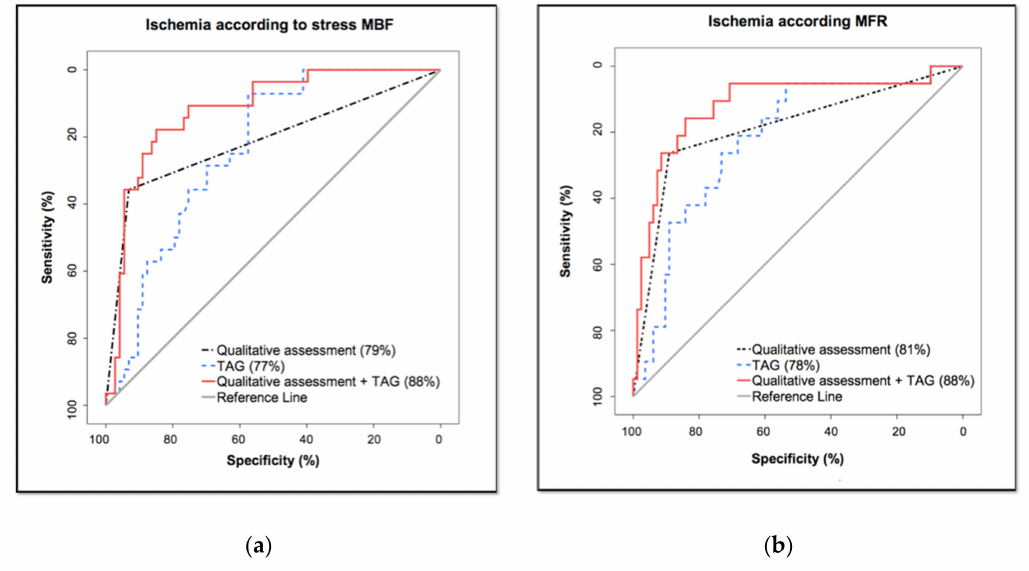
Figure 1. Receiver operating characteristic curve analysis comparing TAG and qualitative assessment of significant stenosis ( ≥ 50%) to ischemia according to: ( a ) stress MBF; ( b )